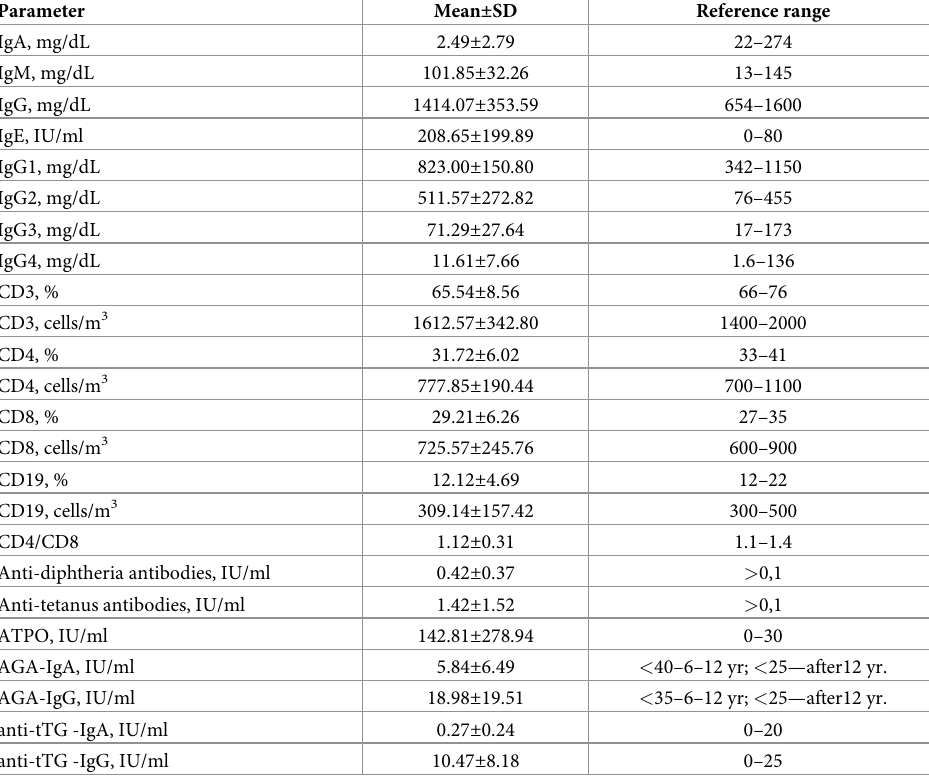
Table 2. The main laboratory findings in patients with DM and